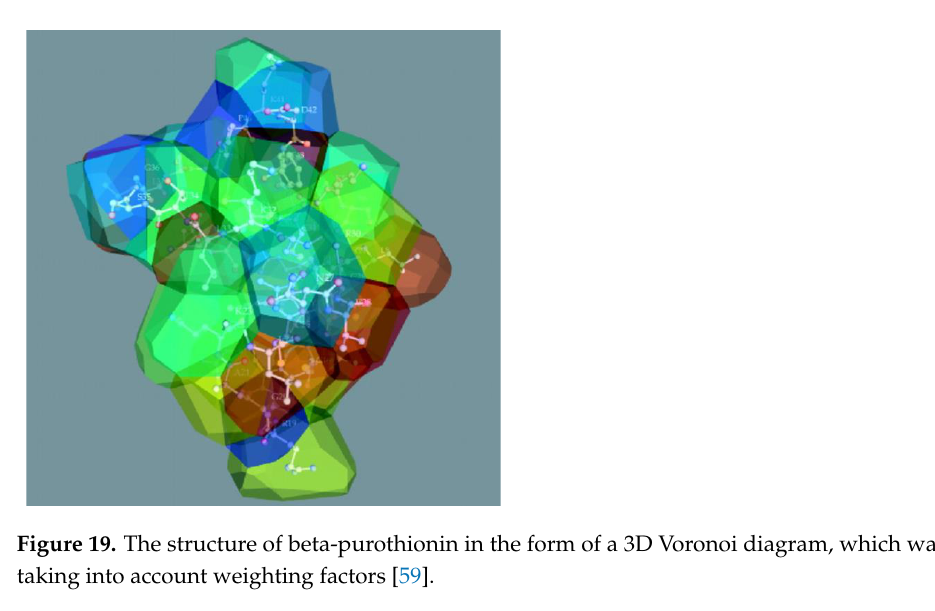
the centroid. This approach makes it possible to obtain curved edges of Voronoi cells.